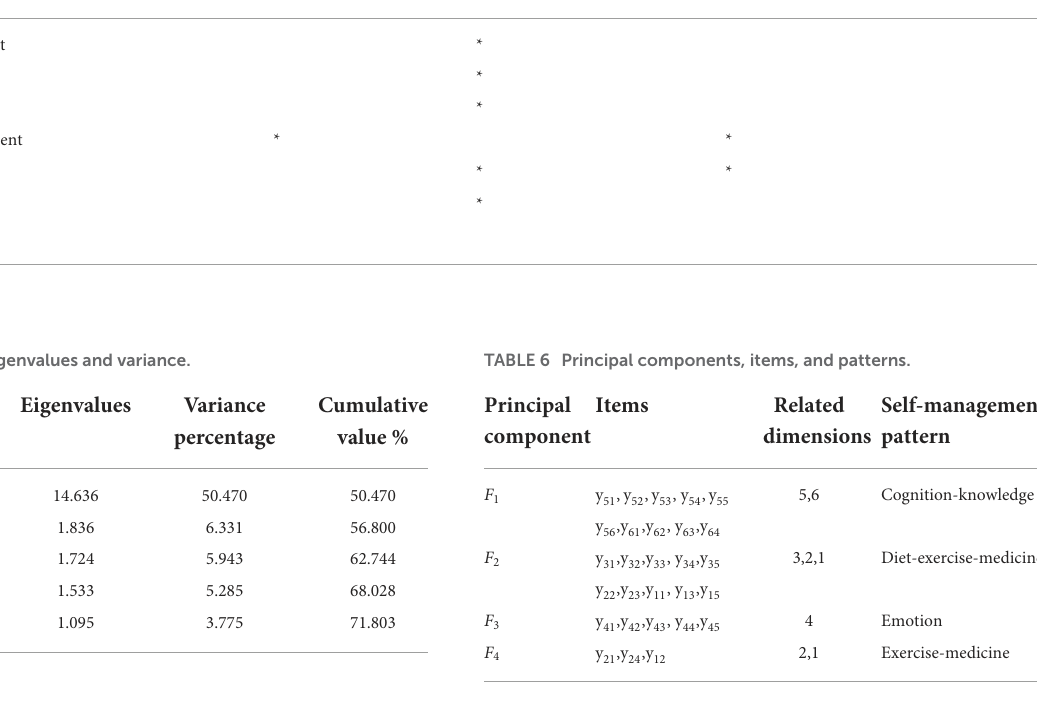
TABLE 5 Principal component and factor (item) load matrix.